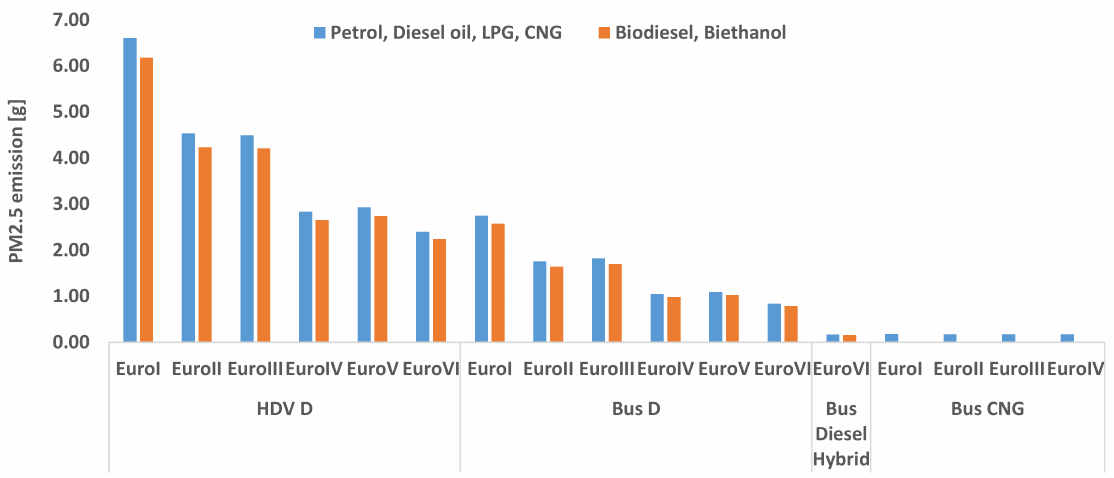
Figure 14. Comparison of PM2.5 emissions from HDVs and buses depending on Euro standard and fuel type.